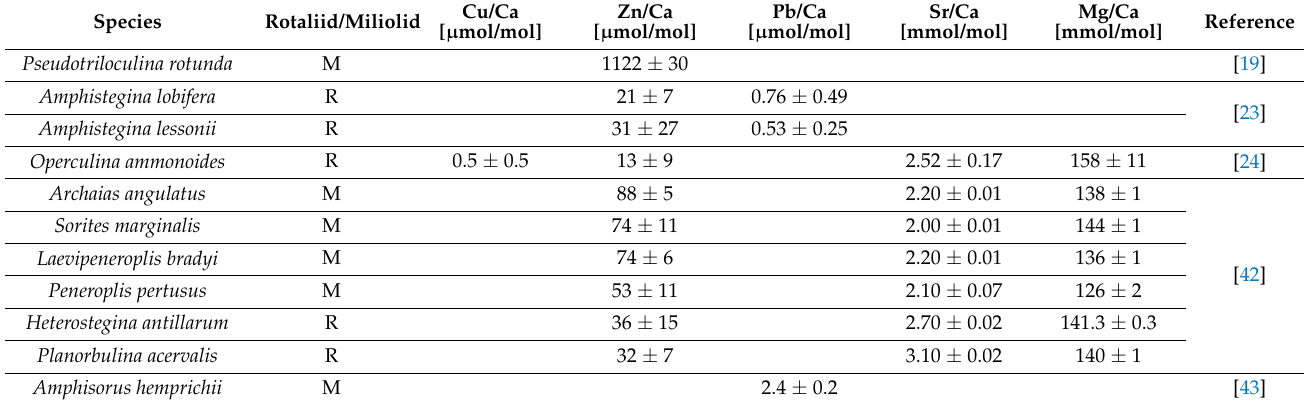
Table 3. Metal/Ca of different foraminifera species from published records. The ratios represent the values of control treatments/field samples. M = miliolid, R =